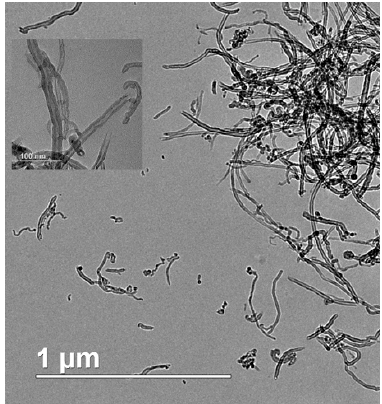
Figure 1. Transmission electron microscopy images of multi-walled carbon nanotubes (MWCNT) powder with the inset image at a higher magnification .